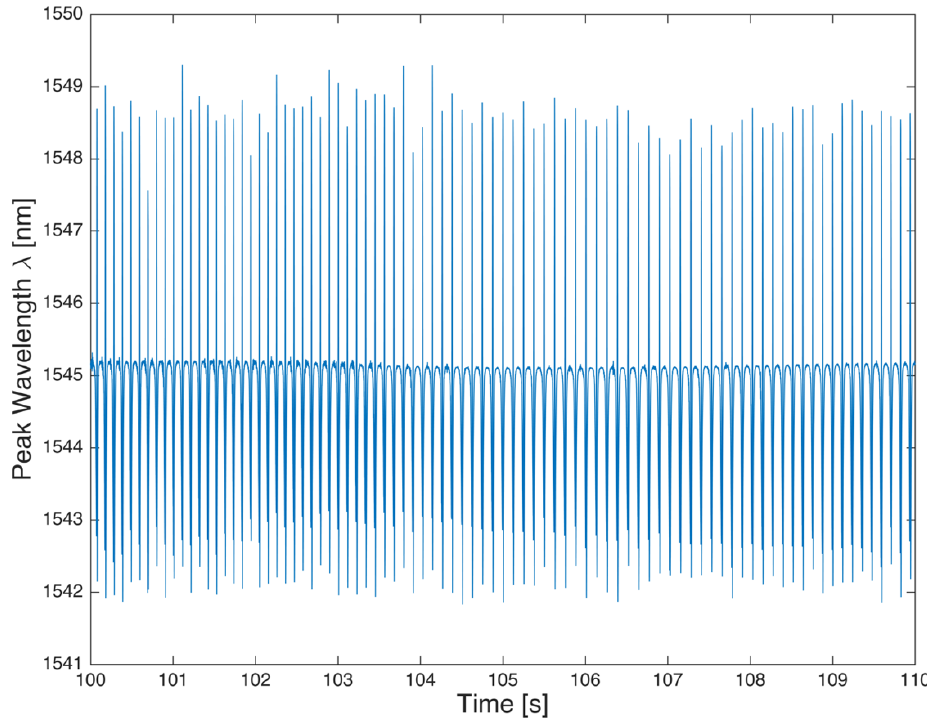
Figure 20. Strain log for the vehicle in steady motion at 40 km/h.